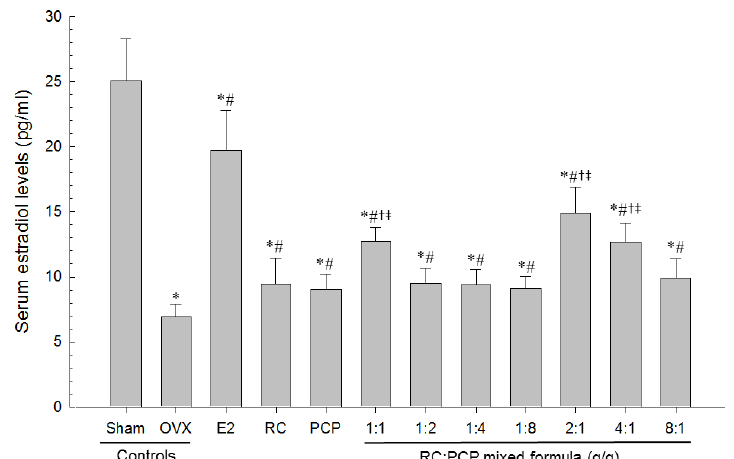
Figure 6. Serum Estradiol Levels in Sham-operated or OVX ddY Mice. Values are expressed mean ± S.D. of eight mice. OVX = Ovariectomy; RC = Red clover dry extracts; PCP = Pomegranate Concentrate Powder; RC:PCP = Mixed formulations consisted of RC and PCP (g/g). * p < 0.05 as compared with sham control; # p < 0.05 as compared with OVX control; † p < 0.05 as compared with RC single formula treated mice; ‡ p < 0.05 as compared with PCP single formula treated mice.